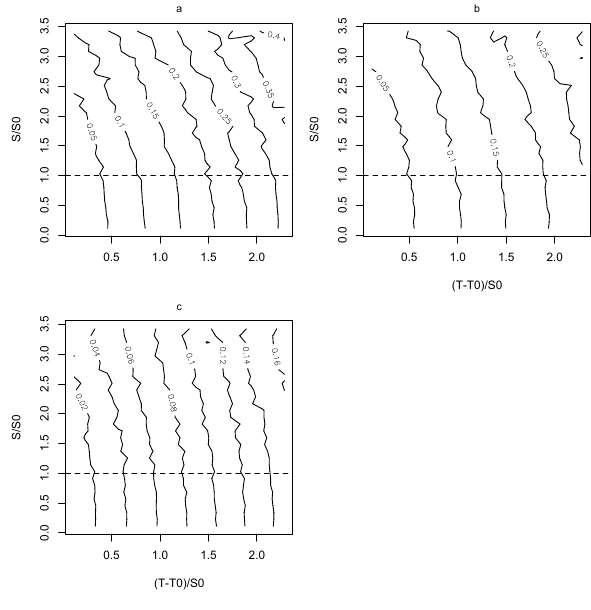
Fig. 5. MSC plots for H.J. Andrews using the modified van’t Hoff equation and Q 10 = 4 , 3 , 2, for panels (a) , (b) , and (c) , respectively. Contours represent values of δR , i.e., the proportional increase in respiration over 10yr from one climatic regime over the other.